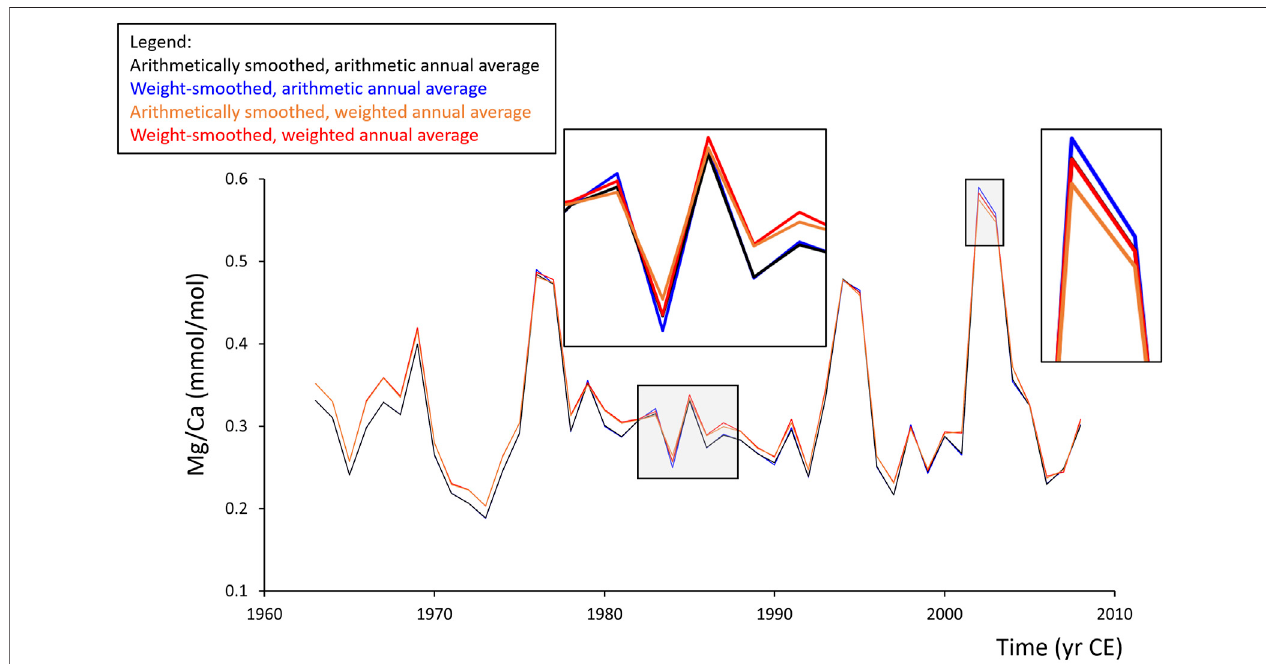
FIGURE 4 | Annual Sr/Ca chronologies of A. islandica specimen GOM090797R2 from the Gulf of Maine ( Table 1 ) computed by different data processing steps. Raw LA-ICP-MS data (acquired in line scan mode) were digitally fi ltered by a 38-pt arithmetic moving average as well as a 38-pt weighted moving average Figure 2 ). Then, arithmetic (black,blue)and weighted(orange,red)annual meanswerecomputedfrom bothdataseries.Whiledatasmoothing(black vs. blue, orangevs. red)had comparatively small effects, the different methods used tocompute annual means resulted in larger offsets (black/bluevs. orange/red), speci fi cally in shell portions formed during early